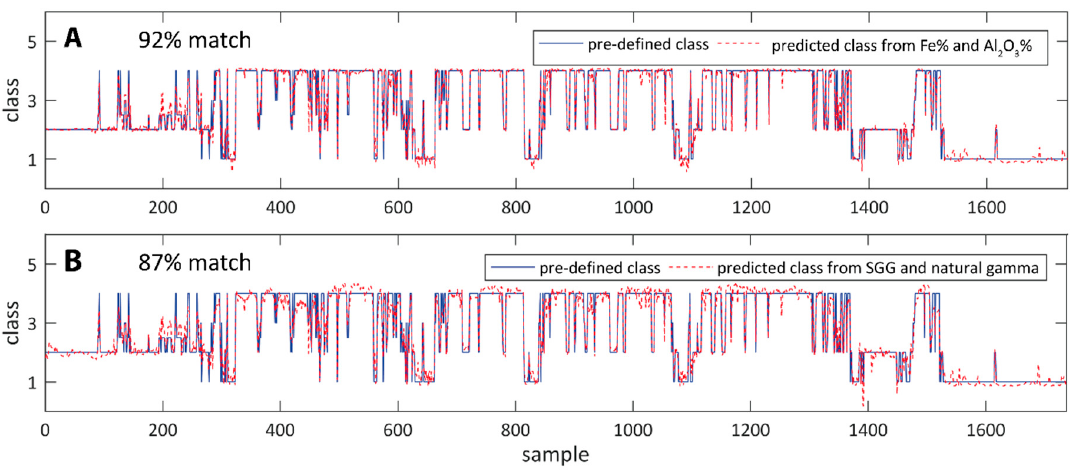
Figure 12. Comparison between predefined classes and predicted classes from elemental data ( A ) and petrophysical logs ( B ). Prediction based on elemental data shows an almost perfect match as would be expected, but prediction from SGG ratio and natural gamma shows a very good result as well.